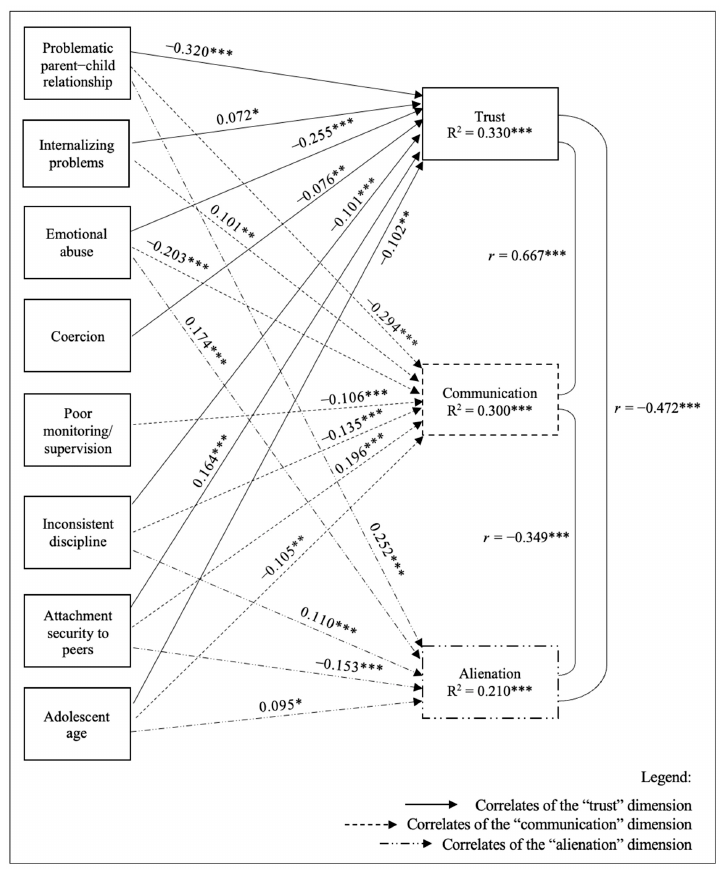
Figure 2. Factors associated with attachment security to parent—three dimensions model for boys and girls. Note. * p < 0.05; ** p < 0.01; *** p < 0.001. The reported coefficients are standardized betas. R 2 = R-Squared.